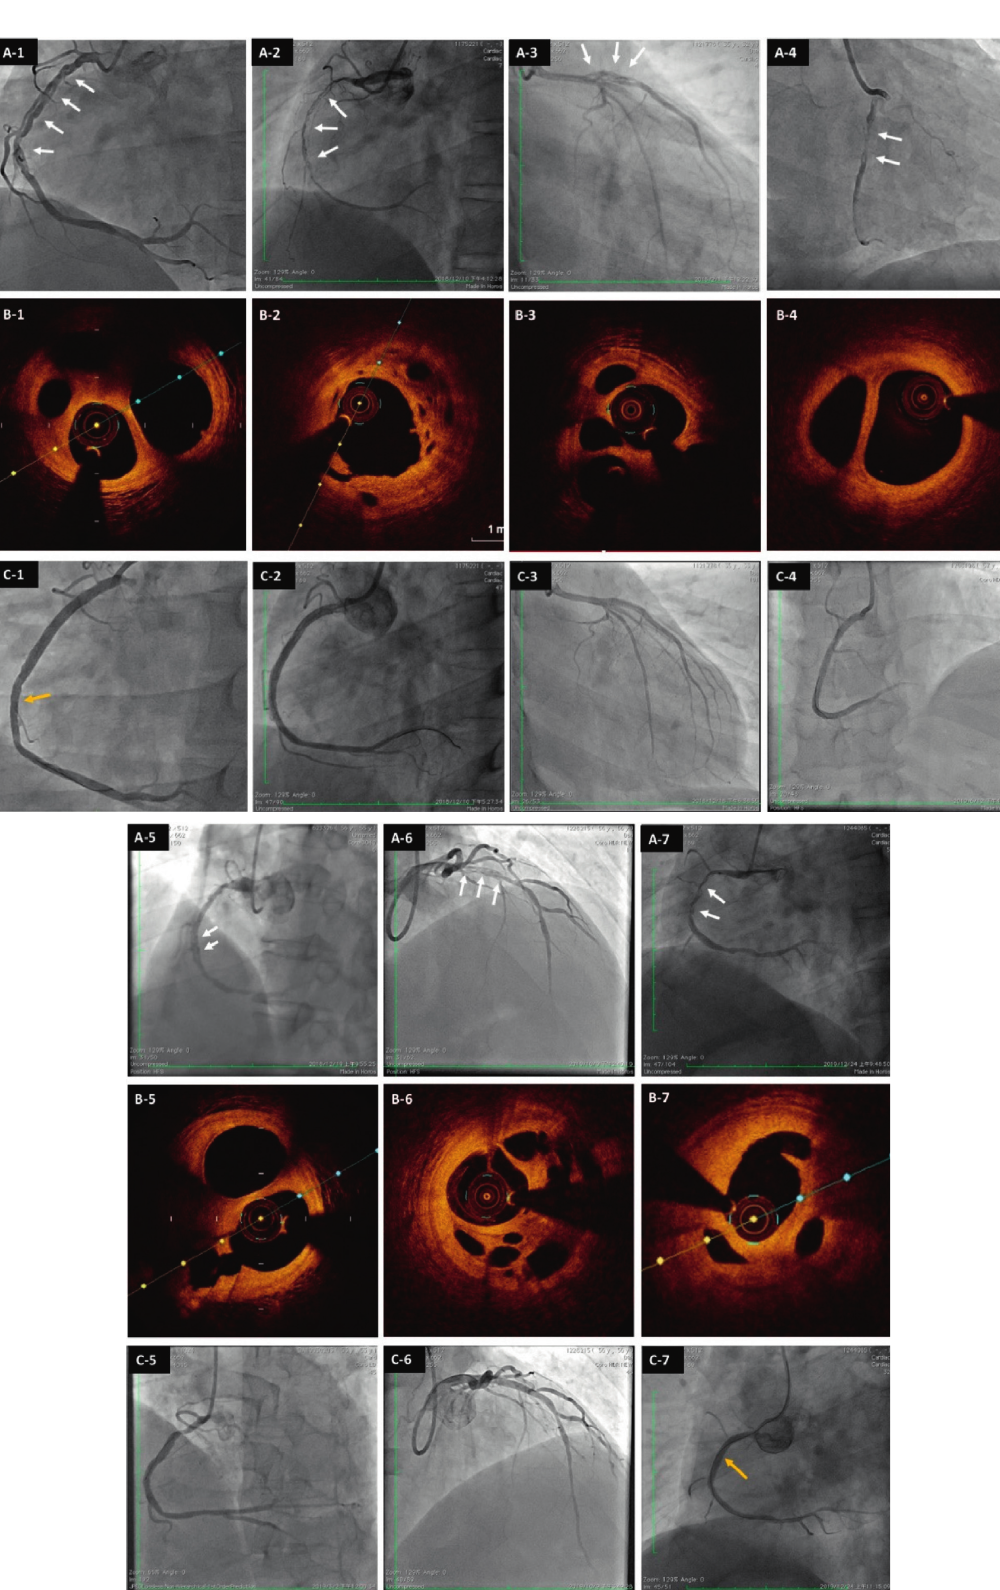
Figure 1: Angiographic and OCT findings of patients #1–# 7 . A1–A7 show the baseline braid-like morphology of the target lesions (white arrow) in patients #1 to #7. B1–B7 show the preprocedural lotus root-like OCTimages of the target lesions in patients #1 to #7. C1–C7 show the angiographic results after stent implantation. Side branch compromise after stent deployment occurred in patients #1 and #7 (yellow